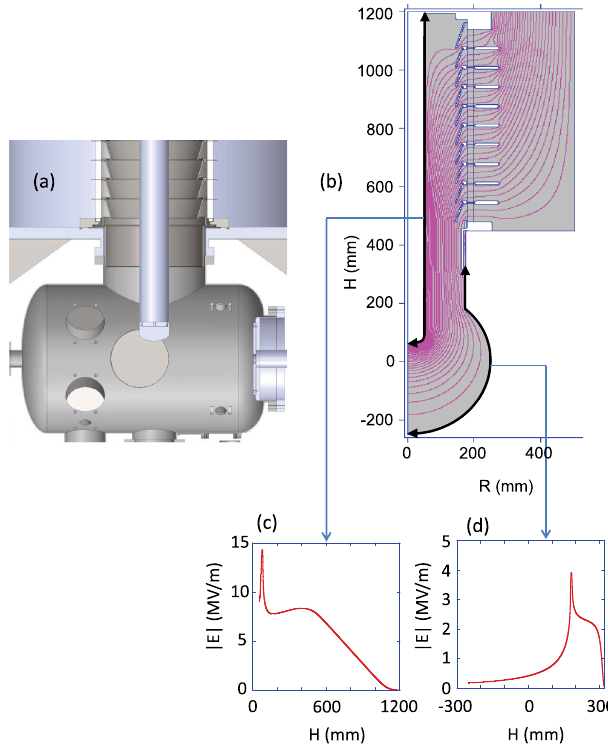
FIG. 11. (a) Cutaway drawing of gun chamber configuration (D) without cathode electrode and (b) radial cross section showing calculated static electric field for gun chamber. Surface electric field distributions (c) of the cathode as a function of height H along the center of the stem electrode and (d) of the anode as a function of H at 500 kV.